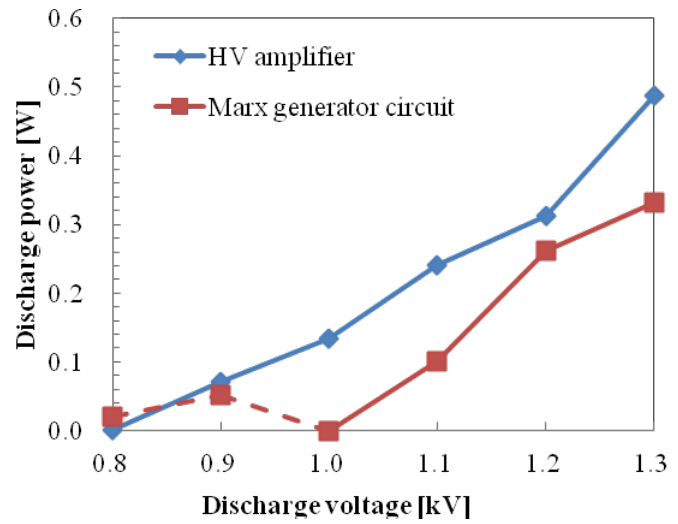
Figure 7. Characteristic discharge power of both power